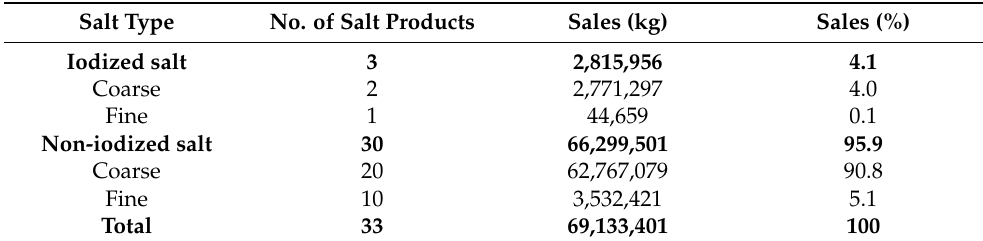
Table 1. Salt sales from 2010 to 2021.